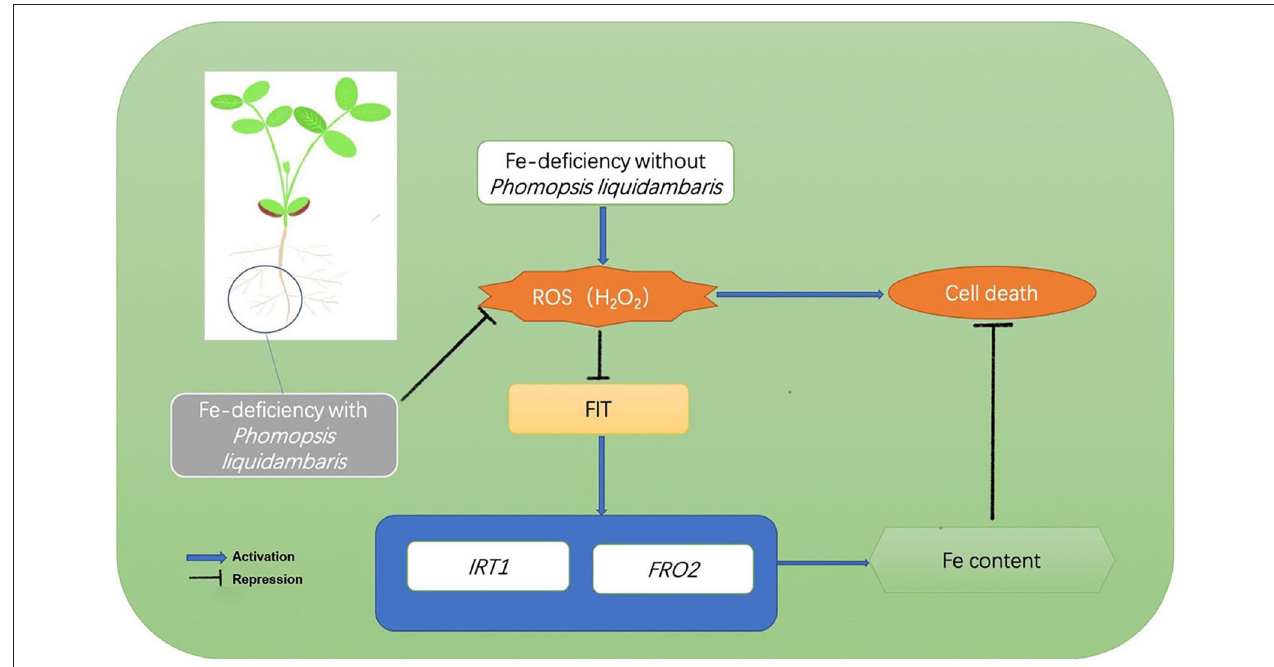
FIGURE 9 | Model of H 2 O 2 -mediated inhibition of Fe acquisition. Under Fe deficiency, H 2 O 2 was upregulated. H 2 O 2 represses the transcription of FIT , consequently reducing the expression of Fe uptake genes IRT 1 and FRO2 and decreasing Fe acquisition from the environment. The colonization of P. liquidambaris help plants reduce the H 2 O 2 content in vivo , thereby releasing the FIT gene inhibited by H 2 O 2 and up-regulating downstream IRT 1 and FRO2 , then promoting the Fe absorption, and the increased Fe absorption alleviating the Fe-deficiency stress of plants.